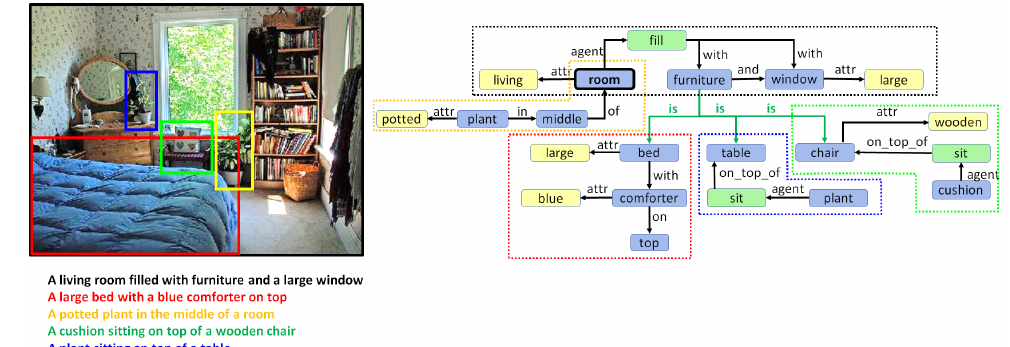
Figure 1. An example showing generated holistic scene graphs ( right ) from images ( left ) using region-specific dependency parse